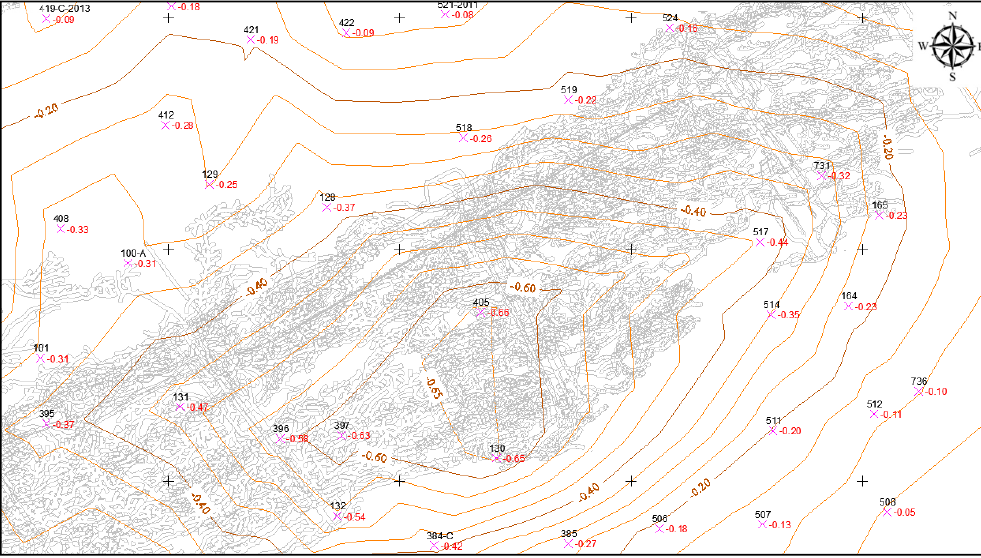
Figure 6. Vector map with the contour lines of subsidence in the most adverse zone from Mine1 between 2013 and 2015. Scale 1:10,000.